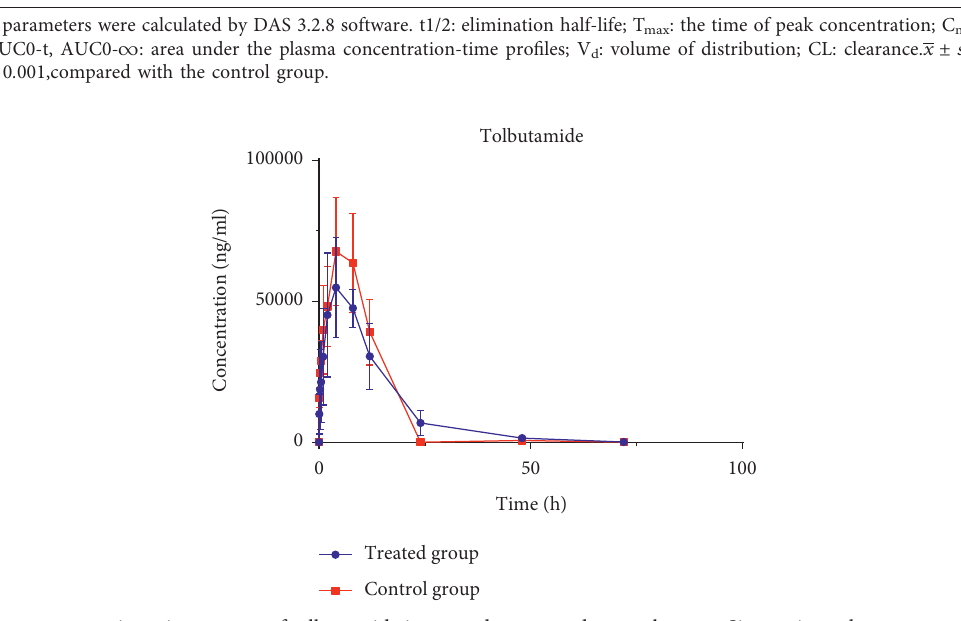
Figure 4: Plasma concentration–time curves of tolbutamide in treated group and control group. Six rats in each group were intragastrically given 20mg/kg of LDR (treated group) or identical volume of 0.5% CMC-Na (control group) for fifteen consecutive days, respectively. The two groups were intragastrically given tolbutamide prepared in 0.5% CMC-Na at a dose of 30mg/kg at the sixteenth day.